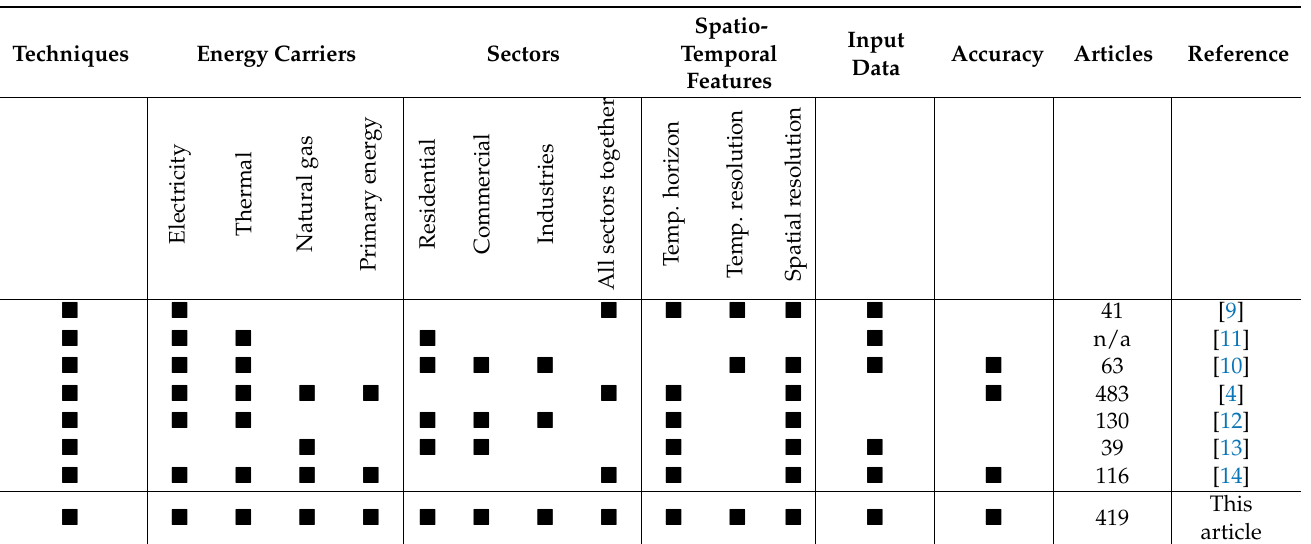
Table 1. Overview of recent systematic literature by content. In each line, black squares ( (cid:4) ) indicate topics covered in the given review. Most reviews cover several sectors or energy carriers and analyze model inputs and spatio-temporal features. Few reviews analyze model accuracies and only the present article covers all the aspects.